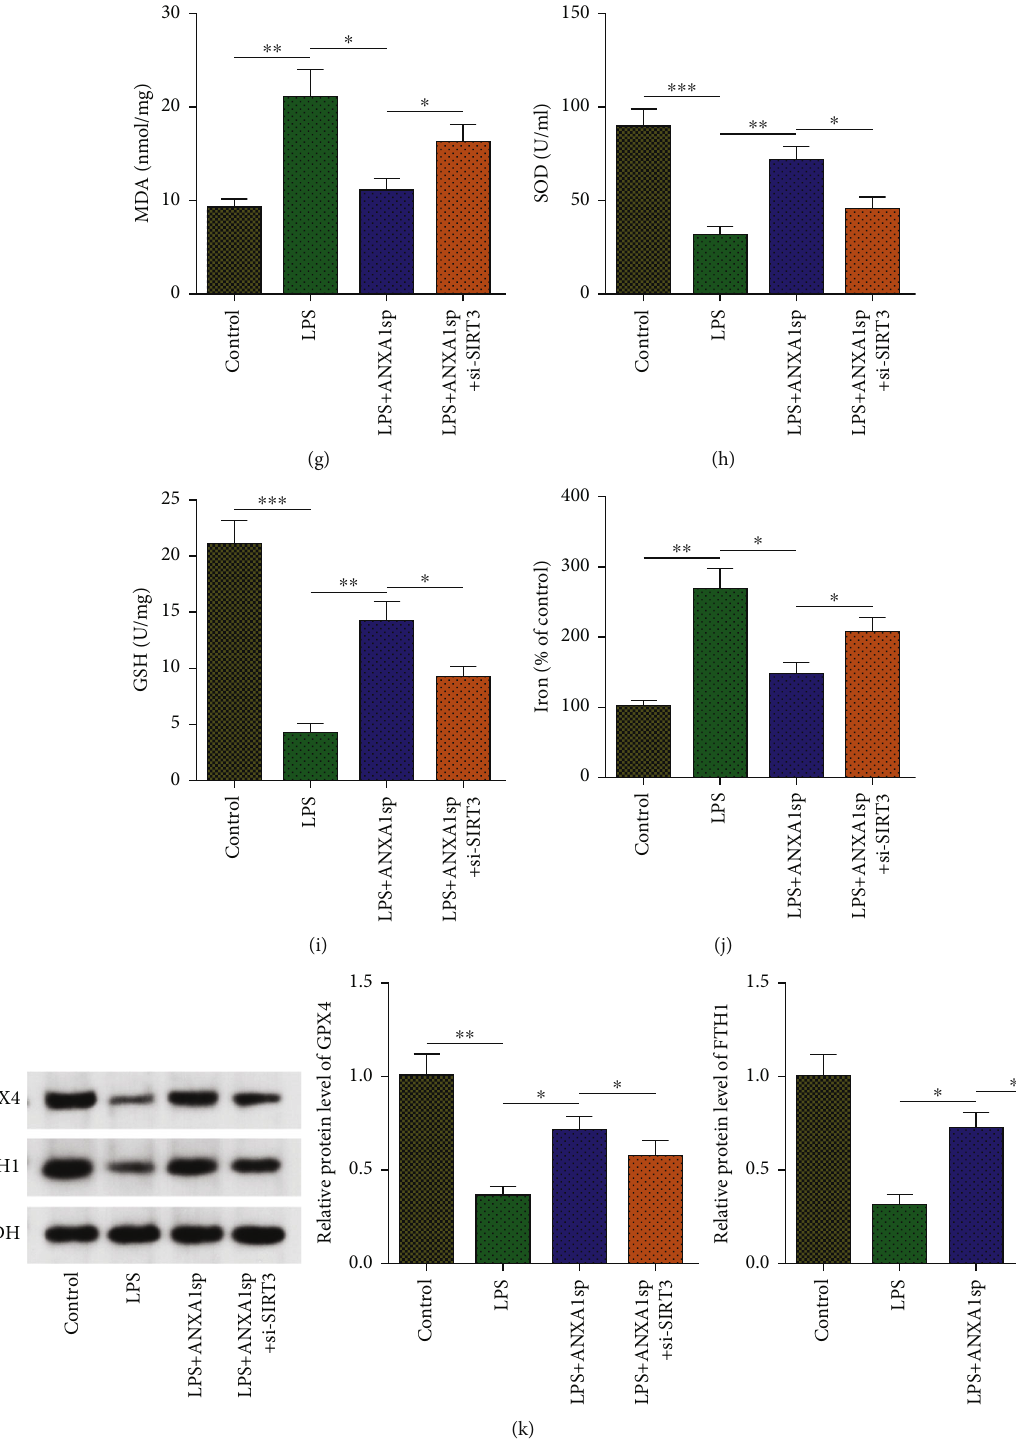
Figure 5: SIRT3 inhibition attenuates the protective e ff ects of ANXA1sp on LPS-challenged H9C2 cells. H9C2 cells were assigned to control, LPS, LPS+ANXA1sp, and LPS+ANXA1sp+si-SIRT3 groups. (a) CCK-8 for H9C2 cell viability. (b) LDH level in H9C2 cell supernatant. (c – e) ELISA for TNF- α , IL-1 β , and IL-6 levels. (f – i) ROS, MDA, SOD, and GSH levels in H9C2 cell supernatant. (j) Iron accumulation in H9C2 cells. (k) WB for levels of ferroptosis-related proteins (GPX4 and FTH1). The experiments were repeated three times ( n = 3 ). Data were presented as mean ± SD . All statistical analyses were performed using Student ’ s t -test or one-way ANOVA. ∗ p < 0 : 05 ; ∗∗ p < 0 : 01 ; ∗∗∗ p < 0 : 001